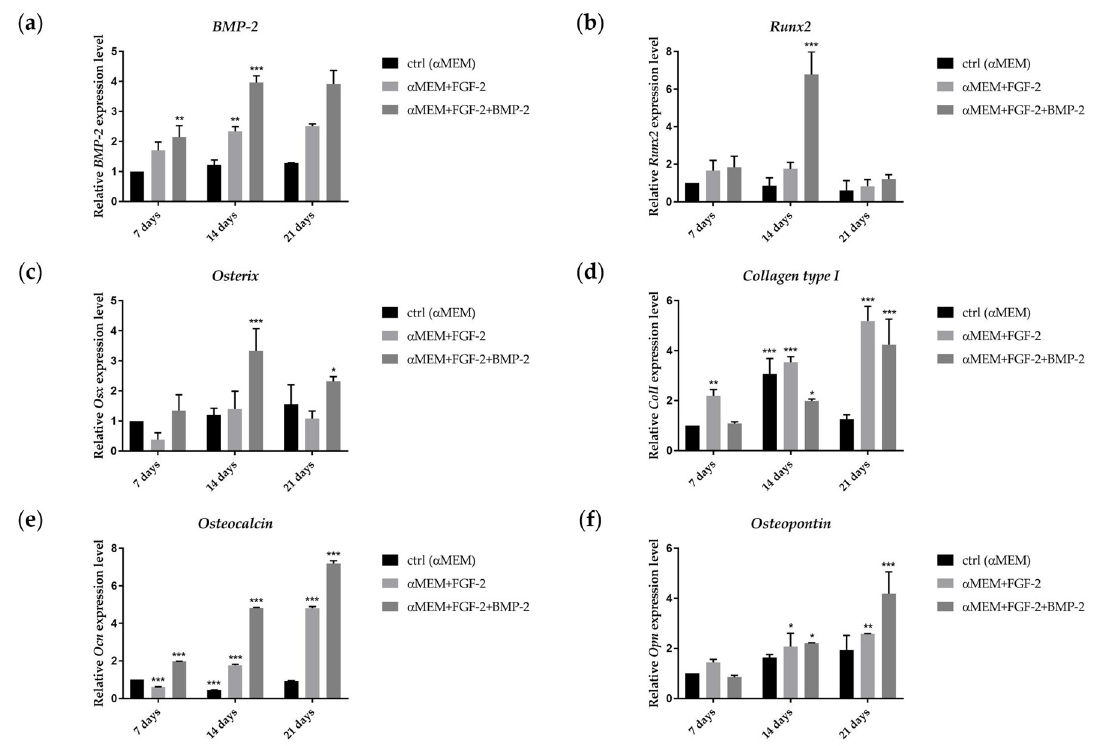
Figure 6. Real-time qRT-PCR analysis for the osteogenic di ff erentiation gene marker of BM-MSCs following treatment with BMP-2 and / or FGF-2 for 7, 14, and 21 days. mRNA for BMP-2 , Runx2 , osterix ( Osx ), and collagen type I ( ColI ) ( a – d ) characterizes the early stage of osteogenesis; osteocalcin ( Ocn ) and osteopontin ( Opn ) ( e , f ) characterize the expression in the late stage of di ff erentiation into osteogenic cells. Three di ff erent experiments were performed. * p < 0.05, ** p < 0.005, *** p < 0.0001.